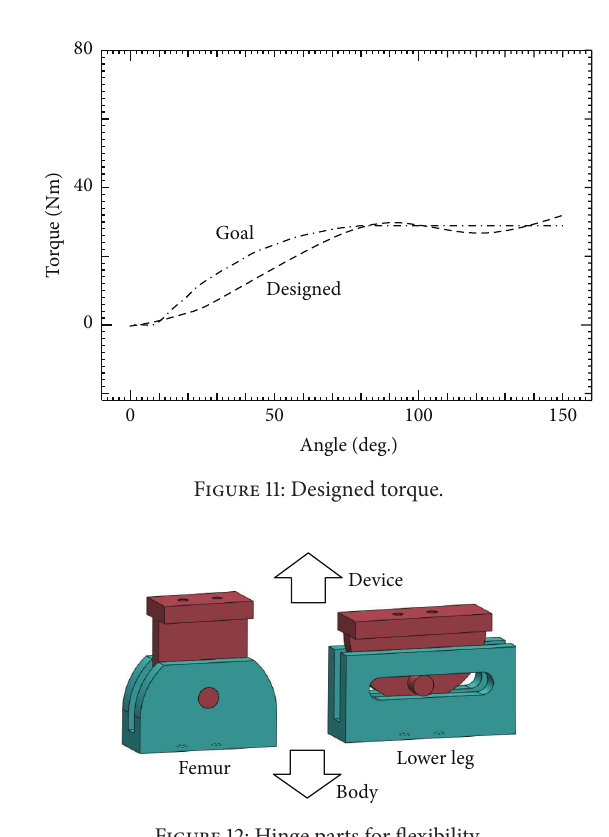
Figure 10: Motion of the torque adjustment mechanism.